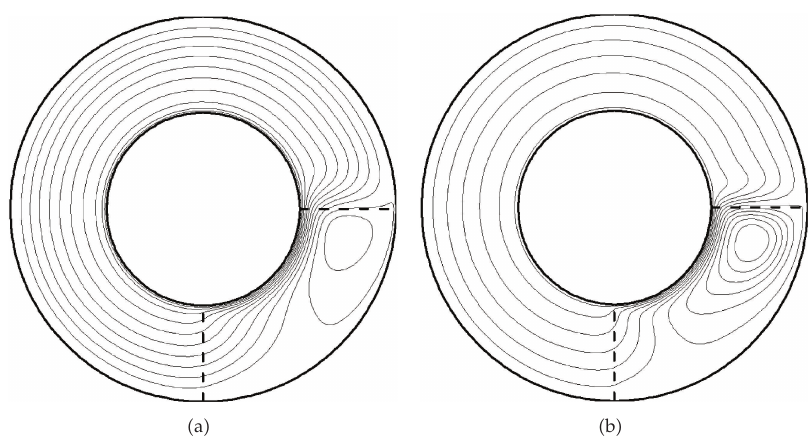
Figure 9: Distributions of the contours of stream function for a three-quarter-circular external magnetic fluids of (cid:2) a (cid:3) Ha (cid:8) 30 and (cid:2) b (cid:3) Ha (cid:8) 50 (cid:2)Δ ψ (cid:8) 0 . 0025 (cid:3)